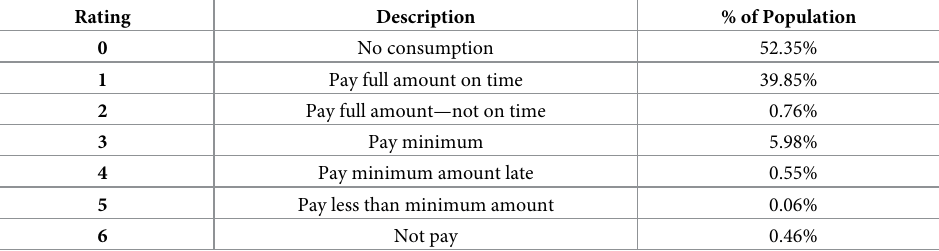
Table 2. Bill data consumer rating summary.